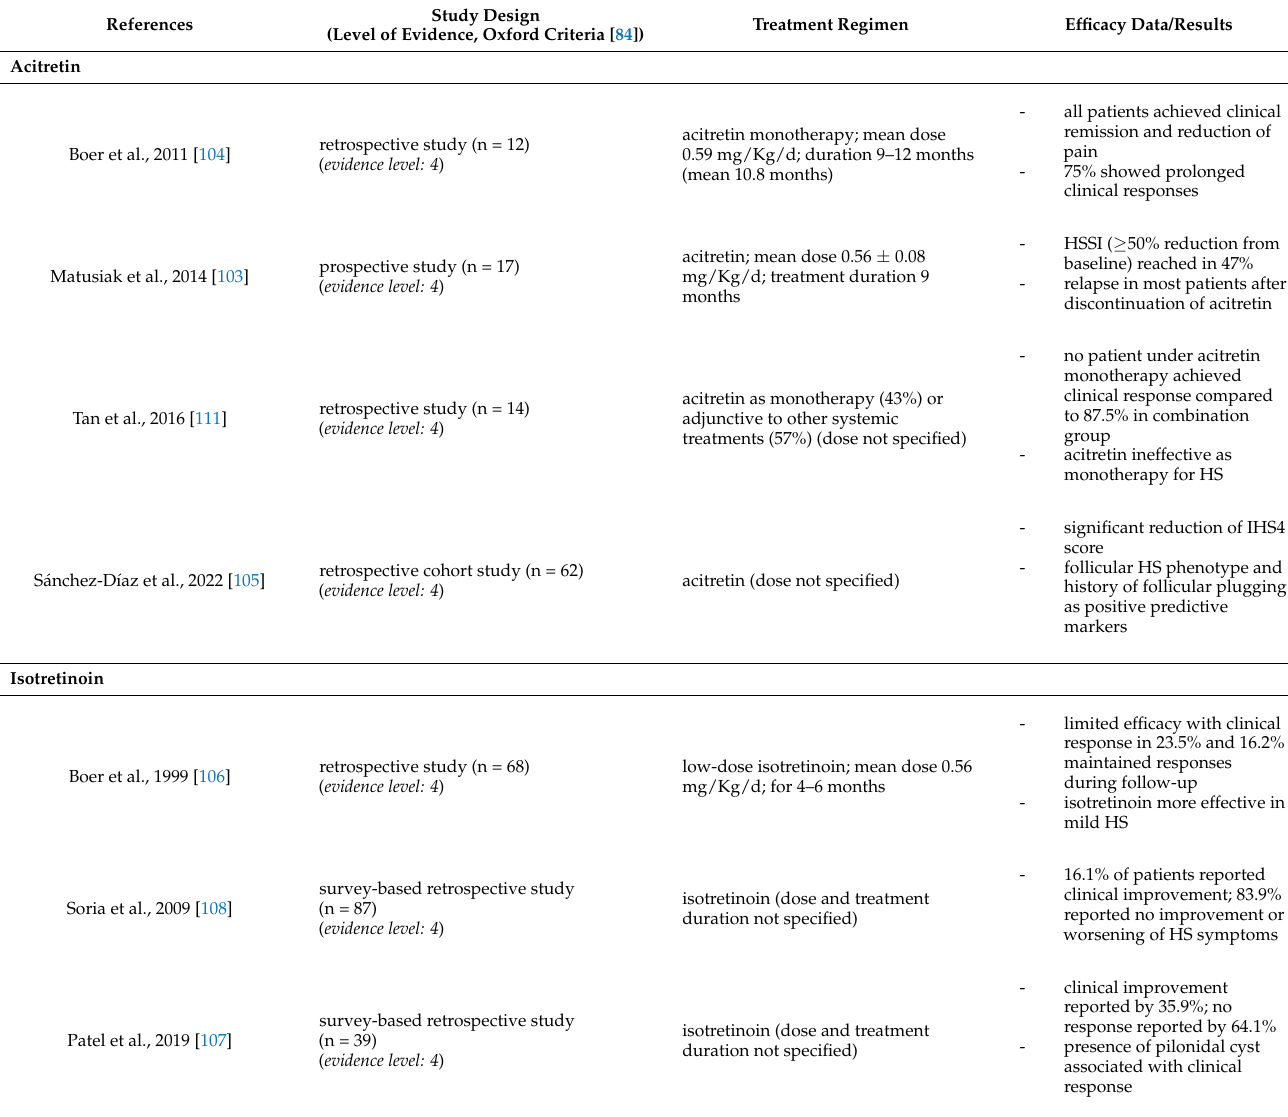
Table 3. Clinical studies evaluating retinoids for HS